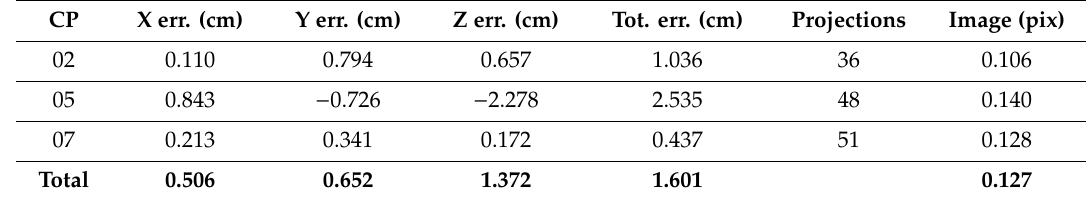
Table 4. Check point errors in the vertical-only acquisition